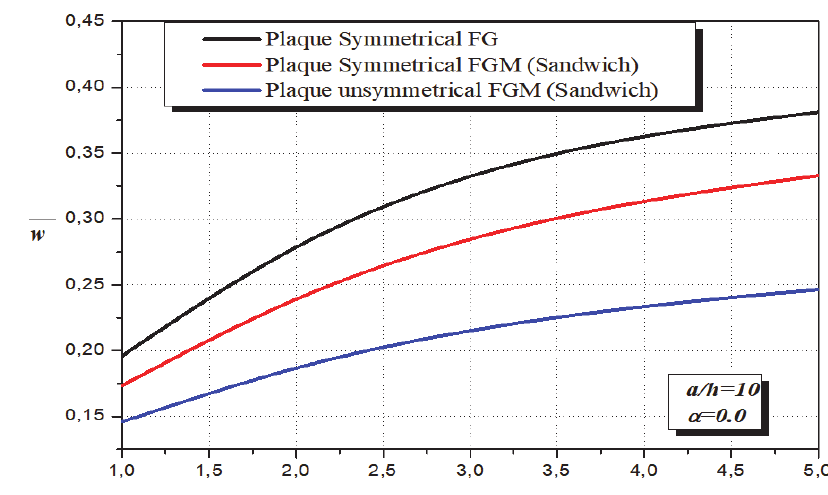
Figure 3: Displacement variation as a function of the power index P and the porosity factor α =0 of sandwich plate FGM.